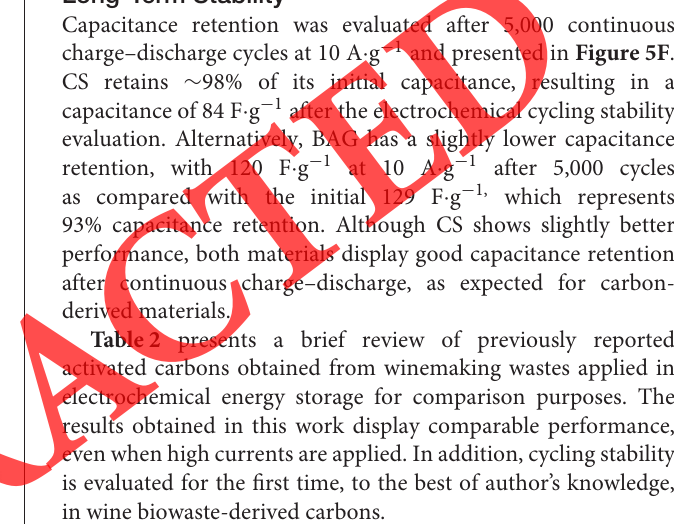
FIGURE 4 | Deconvolution of the C 1s core-level spectra for (A) BAG and (B) CS